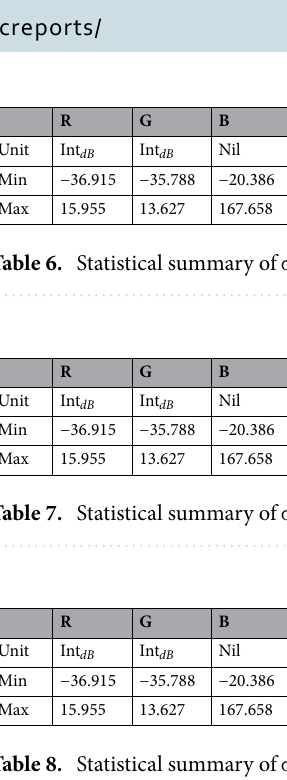
Table 8. Statistical summary of σ